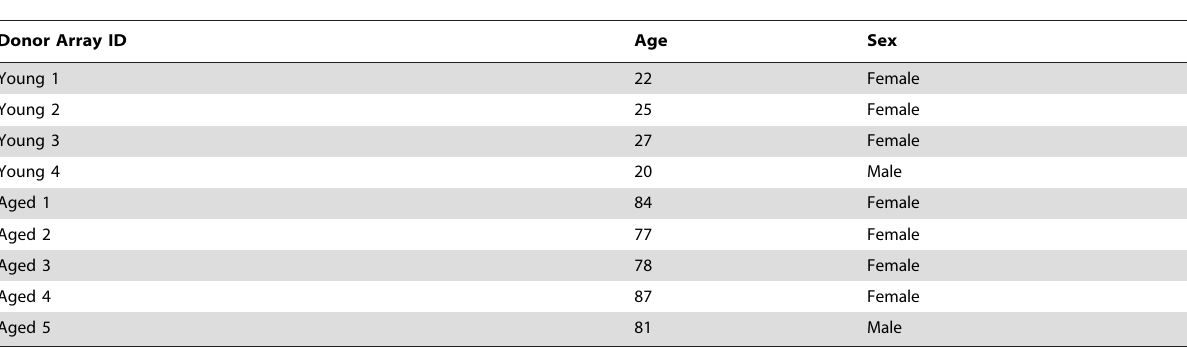
Table 1. MoDCs donor characteristics for microarray data.